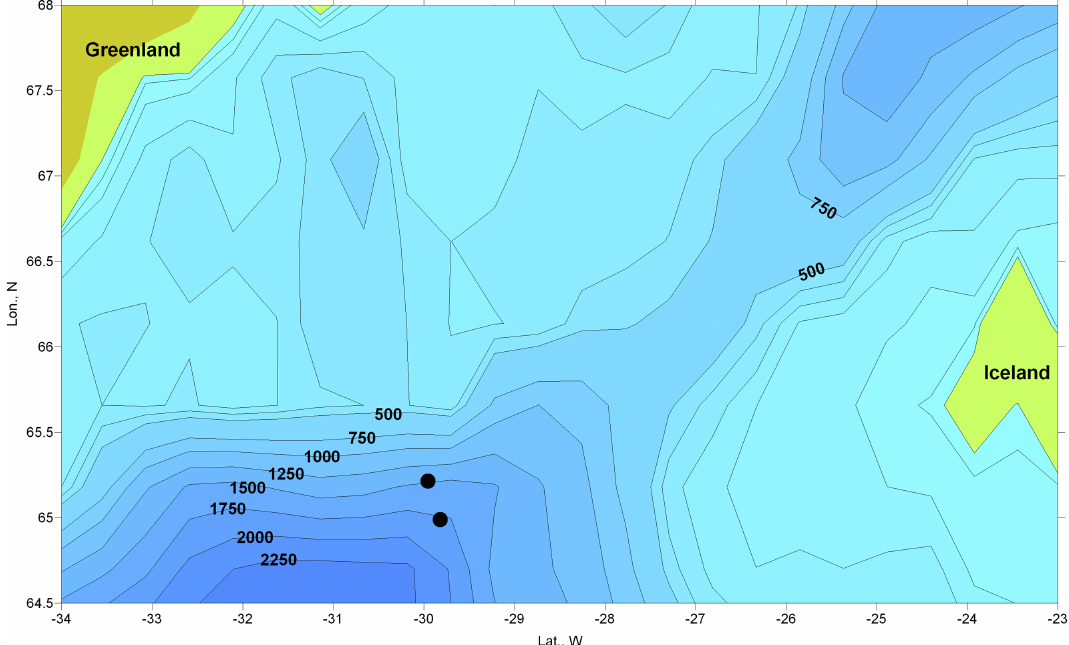
Fig. 3. The research area in 2012. The locations of the stations with MSP/CTDO/LADCP measurements are marked by black